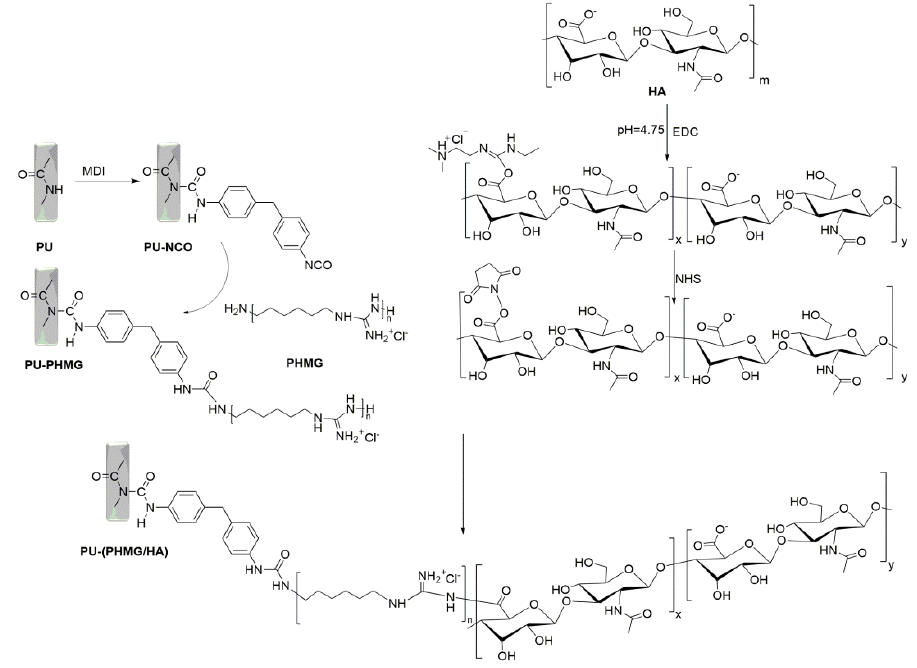
Figure 1. Synthesis procedure for the PU-(PHMG/HA) films.